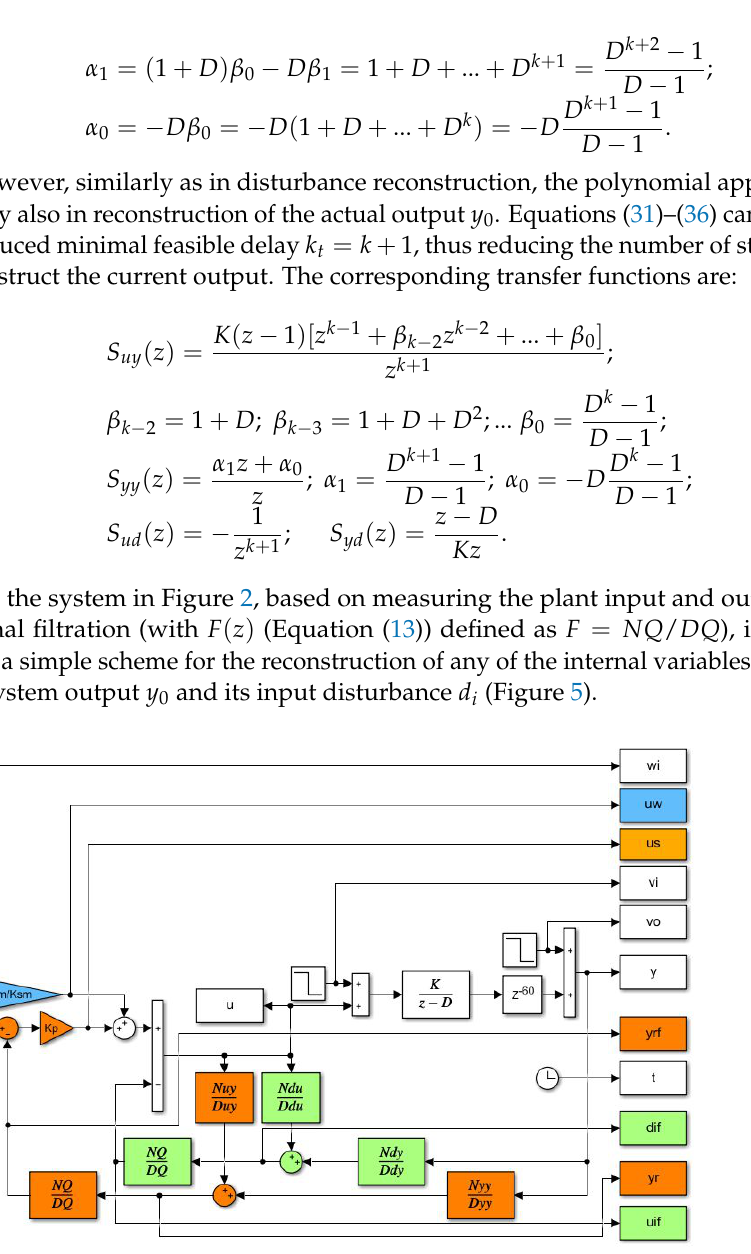
Figure 5. Reconstruction and filtration of an input disturbance d i and of an undelayed first-order plant output y 0 in Matlab/Simulink for T d = 4 T s : the static setpoint feedforward (blue), the setpoint tracking circuitry with the actual output reconstruction, filtration and the stabilizing controller K p (orange) and the disturbance reconstruction, filtration and compensation